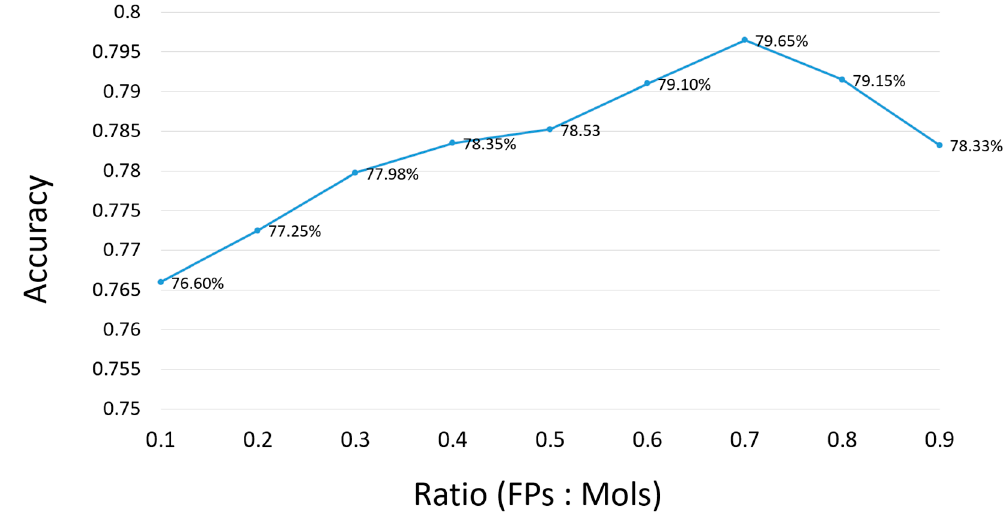
Figure 3. Select best weight ratio of fingerprints to molecular descriptors. Abbreviations: FPs, fingerprints; Mols, molecular descriptors.